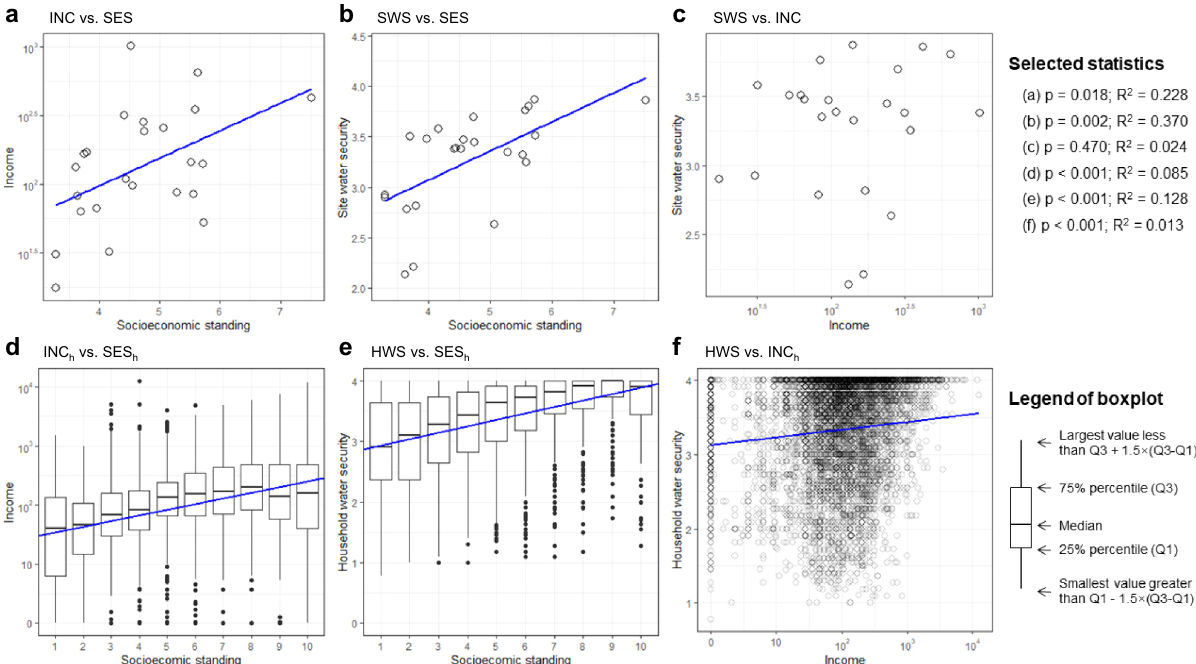
Fig. 4 Relationships between income, socioeconomic standing, and water security at the site and household levels. The upper row shows the site-level relationship ( n = 24). INC, SES, and SWS denote income, socioeconomic standing, and water security at the site level respectively. The bottom row shows the household-level relationship ( n = 5955). INC h , SES h , and HWS denote income, socioeconomic standing, and water security at the household level respectively. The relationships were tested by linear regression models and a two-sided p -value threshold at 0.05 was used. a Income vs. socioeconomic standing at the site level (Model 49). b Water security vs. socioeconomic status at the site level (Model 50). c Water security vs income at the site level (Model 51). d Income vs. socioeconomic standing at the household level (Model 52). e Water security vs. socioeconomic status at the household level (Model 53). f Water security vs income at the household level (Model